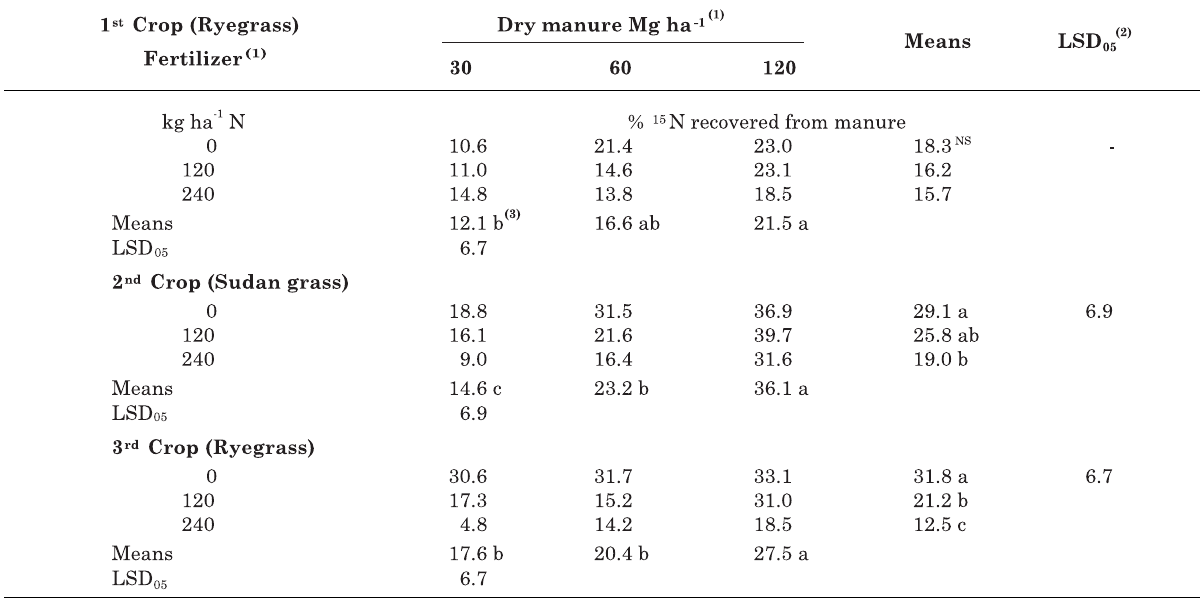
Table 2. Percentage of the N in aboveground dry matter that is derived from manure (NDF (annual ryegrass), second (sudangrass) and third (annual ryegrass) forage crops grown under four manure and three fertilizer rates, labeled with 15 N